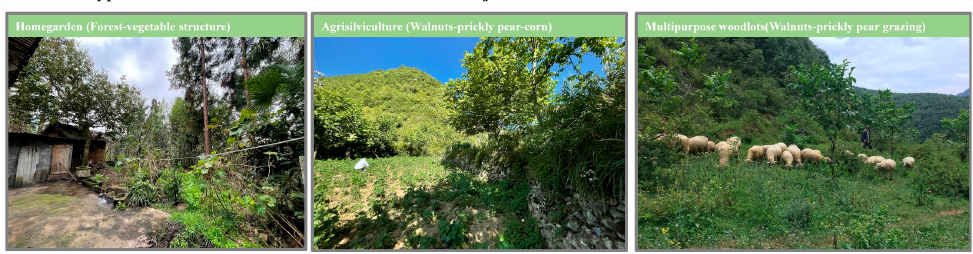
white clover, maize, potatoes, and beans (Figure 2).